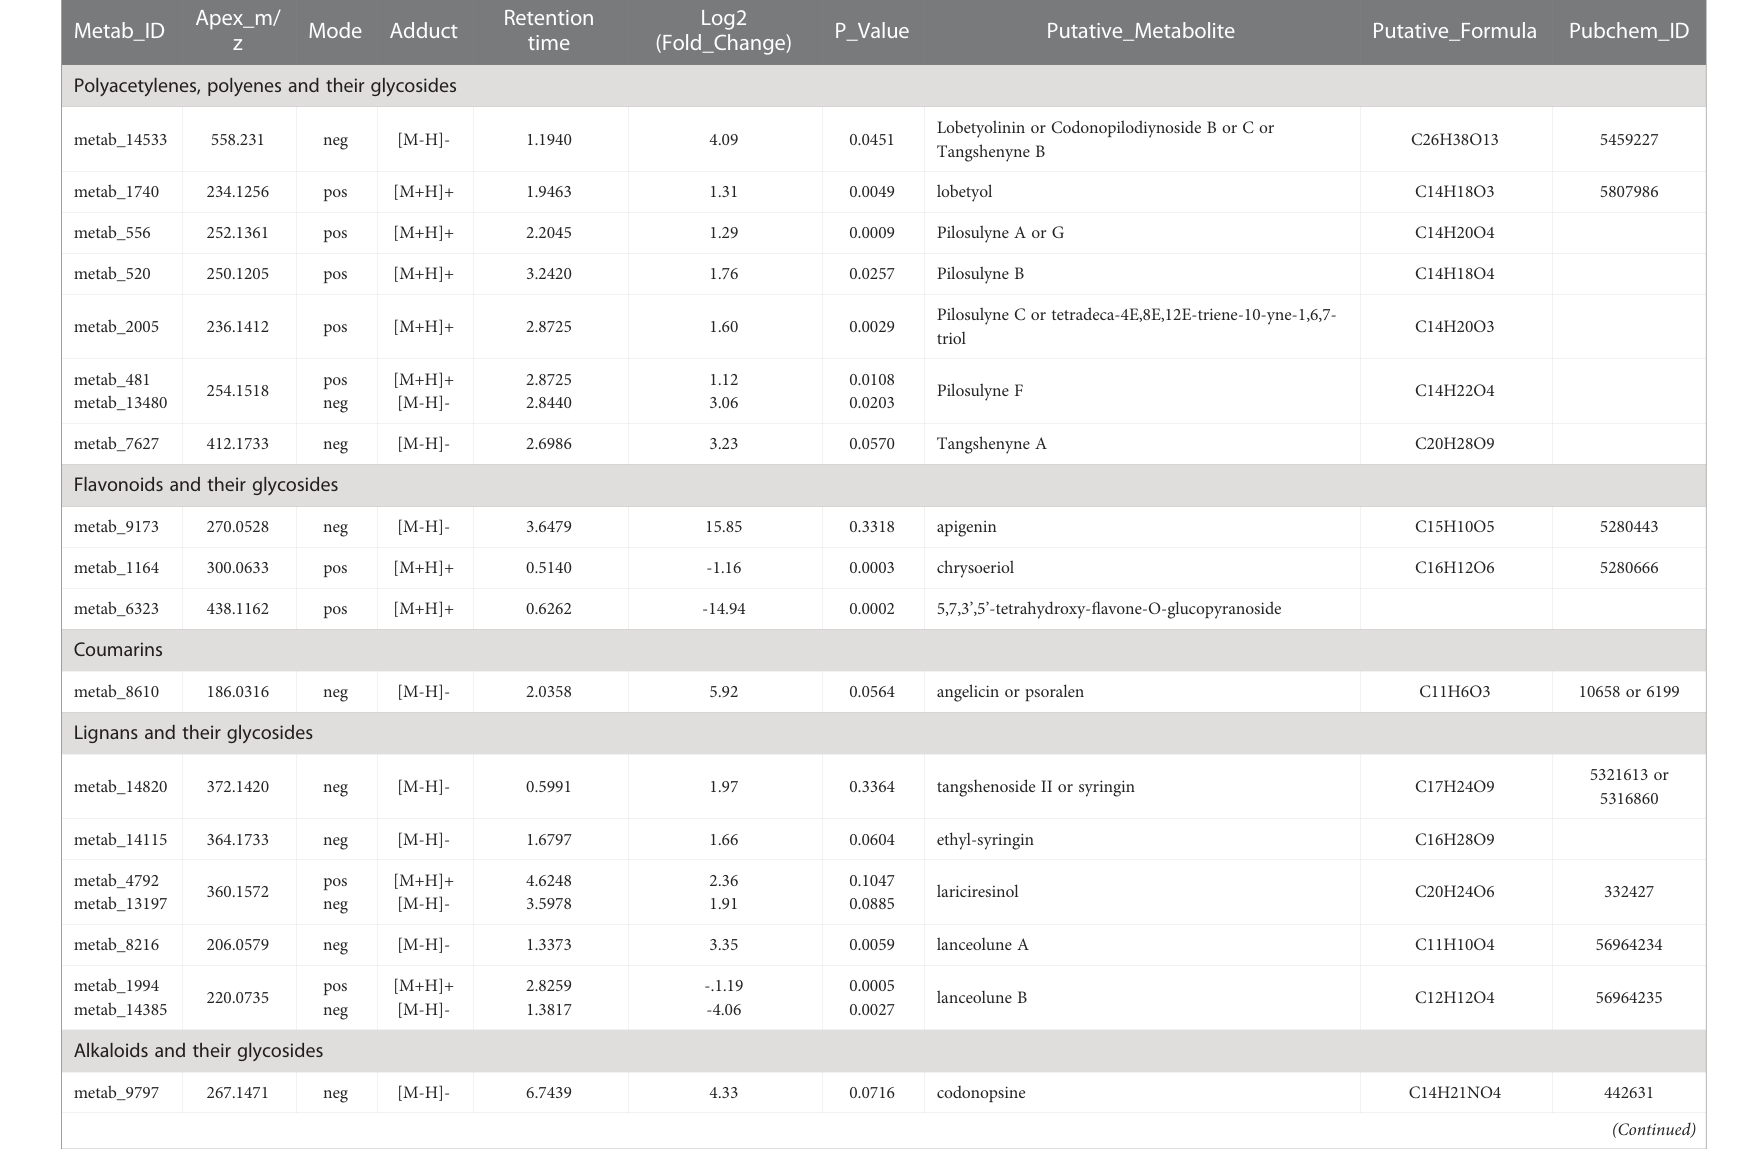
TABLE 2 Differential pythometabolites for comparison bewteen mushrooms from CSL and control group.